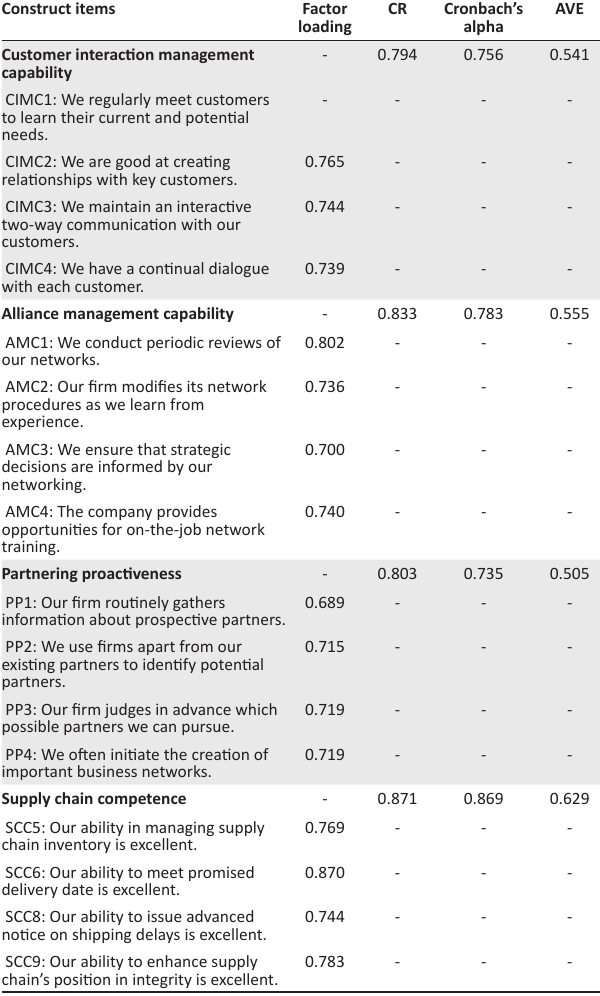
TABLE 2: Validity and reliability assessment. Construct items